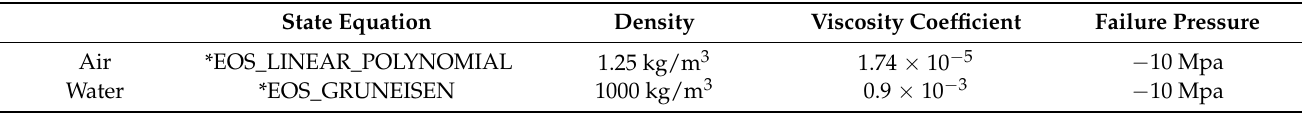
Table 3. Main parameters of water and air in finite element